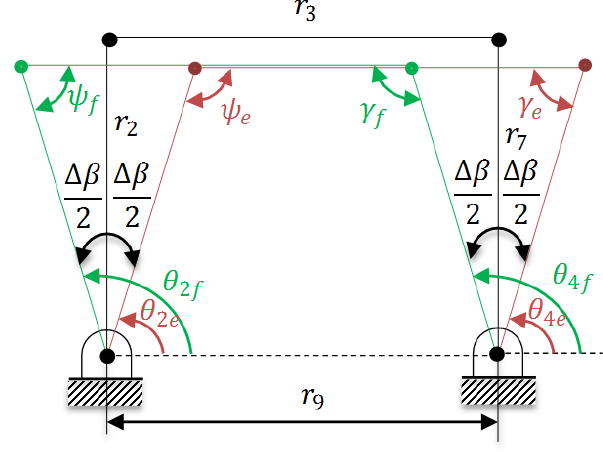
Figure 7. Four-bar mechanism in three positions.